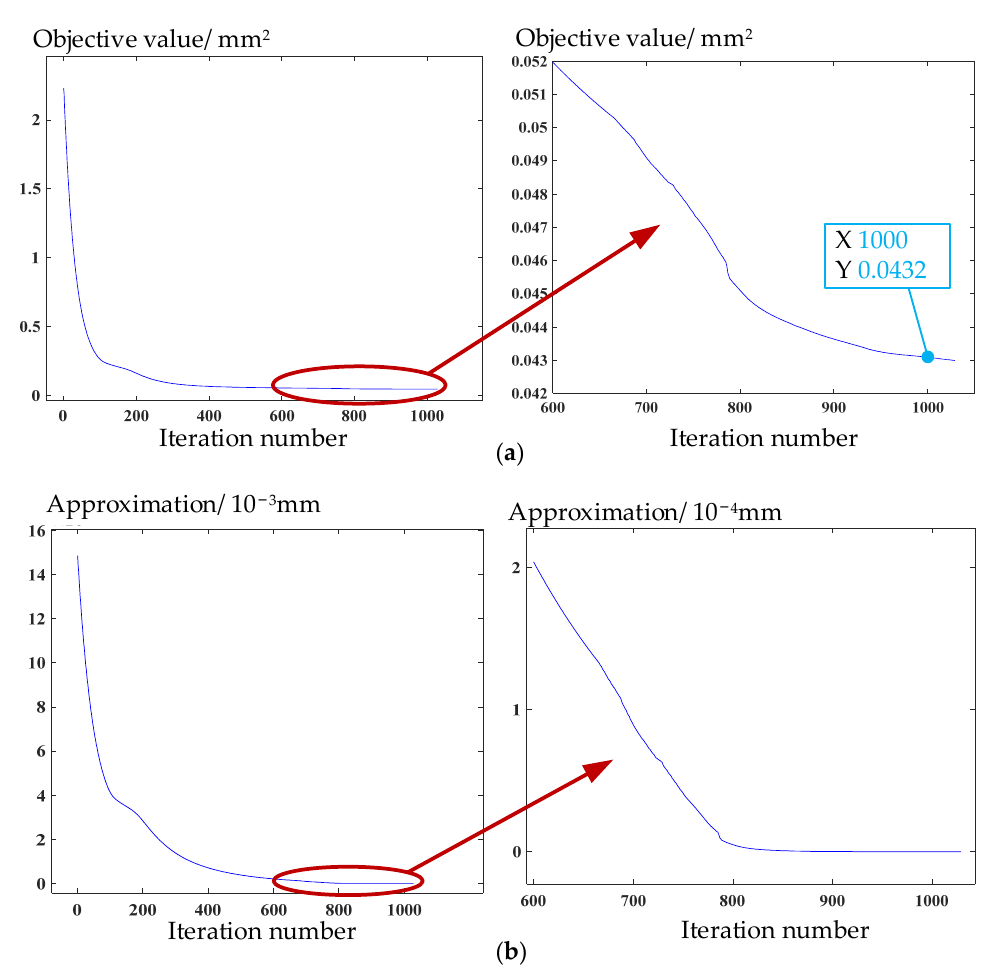
Figure 8. Convergence curves of ( a ) objective value and ( b ) iterative solution in the third stage of the algorithm. Table 3. The comparison of objective value before and after computing in 3SA.